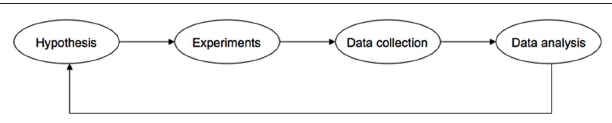
Figure 1 | Biomedical research workflow. Human involvement is essential at each of the steps illustrated in this schematic diagram, while computer software and tools will greatly facilitate the process by better storing, representing, and analyzing the data. Thus, it is crucial to include ontologies and standards at each of these steps for unambiguous interpretation of data by both human and